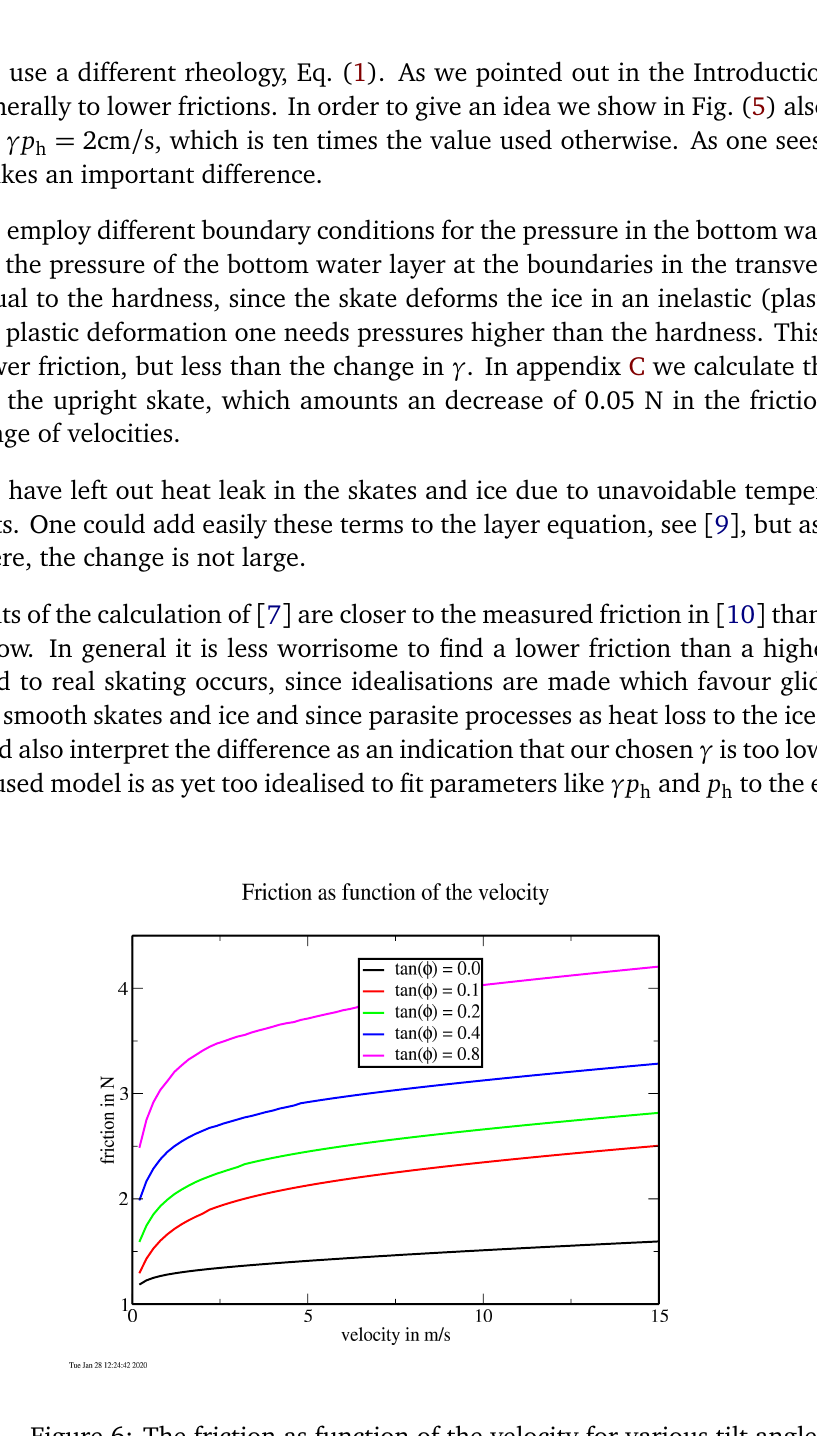
Figure 6: The friction as function of the velocity for various tilt